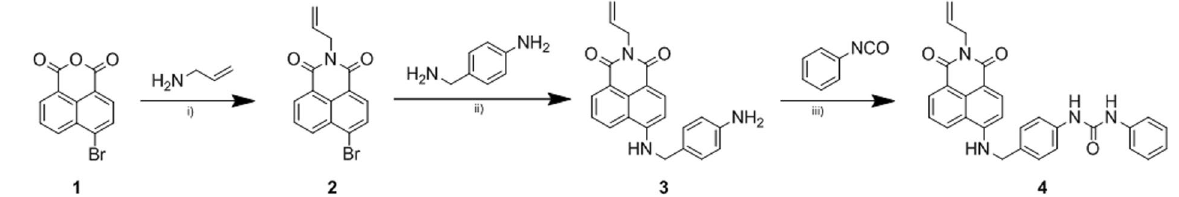
Figure 1. Synthesis of N -allyl-4-(4-( N -phenylureido)benzylamino)-1,8-naphthalimide. i) EtOH, reflux, 3 h, 94% ii) 110 °C, 2 h, 72% for 3, iii) DMF, TEA, r.t, 15–84 h, 4 94%.